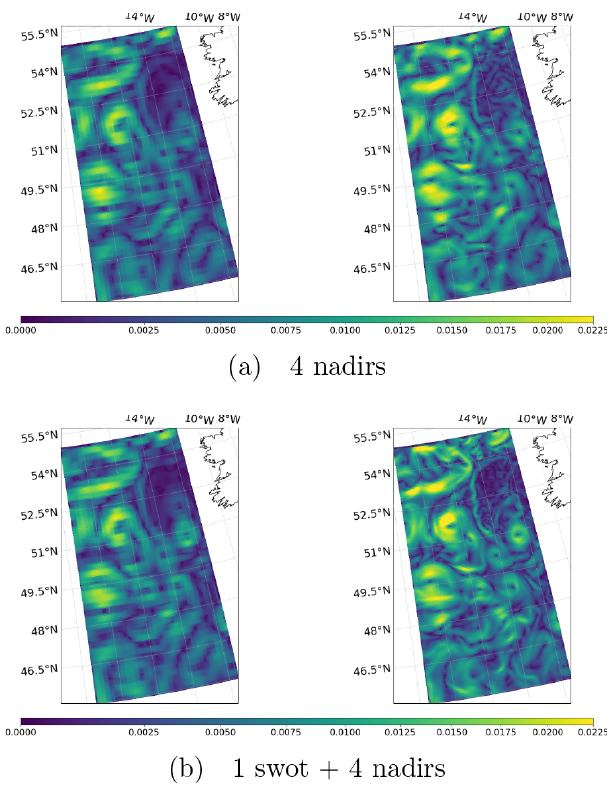
Figure 7. SSH Gradient (DUACS OI and 4DVarNet-SSH recon- struction) on 25 October 2012 for the OSMOSIS